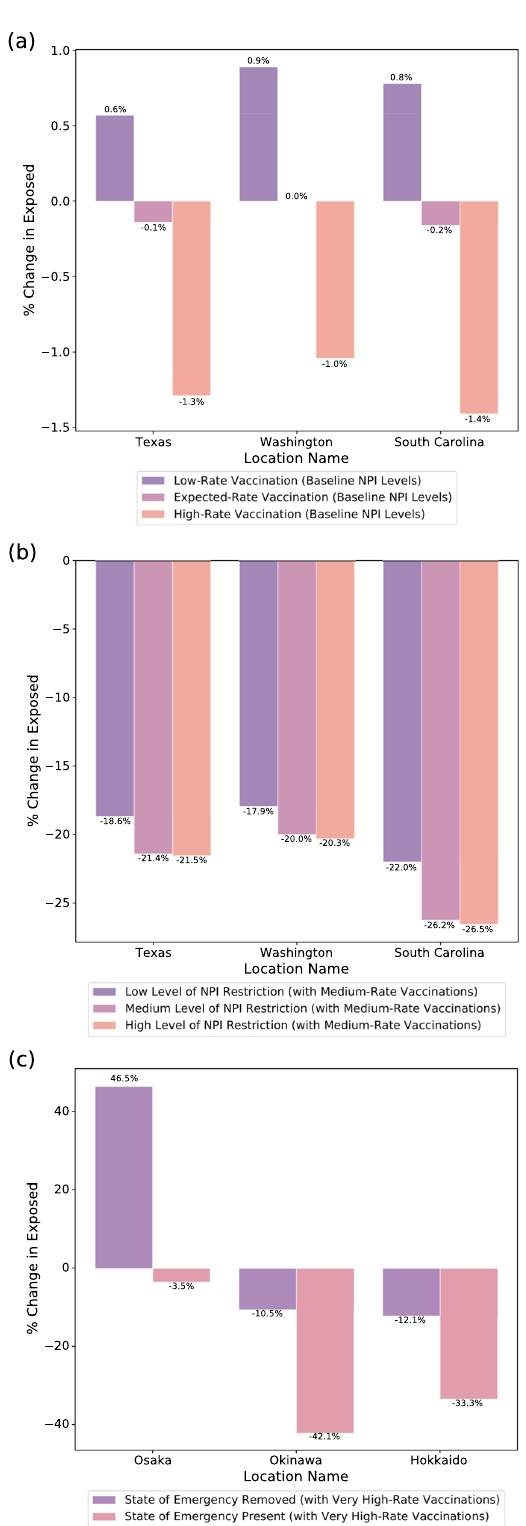
Fig. 7 Counterfactual analysis on the count of predicted exposed individuals for different vaccination rates in tandem with NPIs, for the prediction date of March 1, 2021. a As shown for the three US states, when vaccination rates (low: 0.2 % population/day, medium: 0.5% population/day, high: 1.0% population/day) are increased compared to the expected baseline, which is obtained from the past 4 weeks ’ trend, there is around 1% extra reduction in the predicted exposed. Here, the predicted baseline exposed individual counts are 69,700, 67,600, and 63,700 for Texas, Washington, and South Carolina, respectively. b For these US states, when NPI levels are increased while keeping the vaccination rate 0.5% population/day, we observe a signi fi cant reduction in the number of predicted exposed, >17% across the three states. The majority of the bene fi t is coming from the low-level NPI, due to the school closures being the NPI with the largest impact according to the fi tted model. c In Japan, we show counterfactual analysis assuming a very high vaccination rate (2% population/day), and considering the cases of applying or removing the State of Emergency. Here, the baseline exposed individual counts are 5800, 3800, and 3300 for Osaka, Okinawa, and Hokkaido, respectively. Applying the state of emergency is observed vaccination rate, the predicted exposed cases are observed to go up signi fi cantly. Note that in all cases, because of the uncertainty